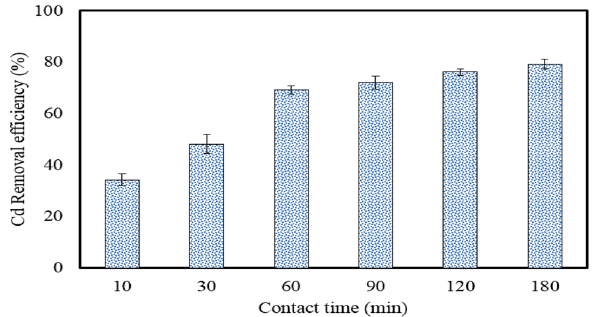
Figure 6. The effect of adsorption time on the removal of Cd by the MBA nano-hybrid. ([Cd] 0 = 40 mg/L, pH = 7.0, adsorbent = 1.0 g/L, temperature = 25 °C).